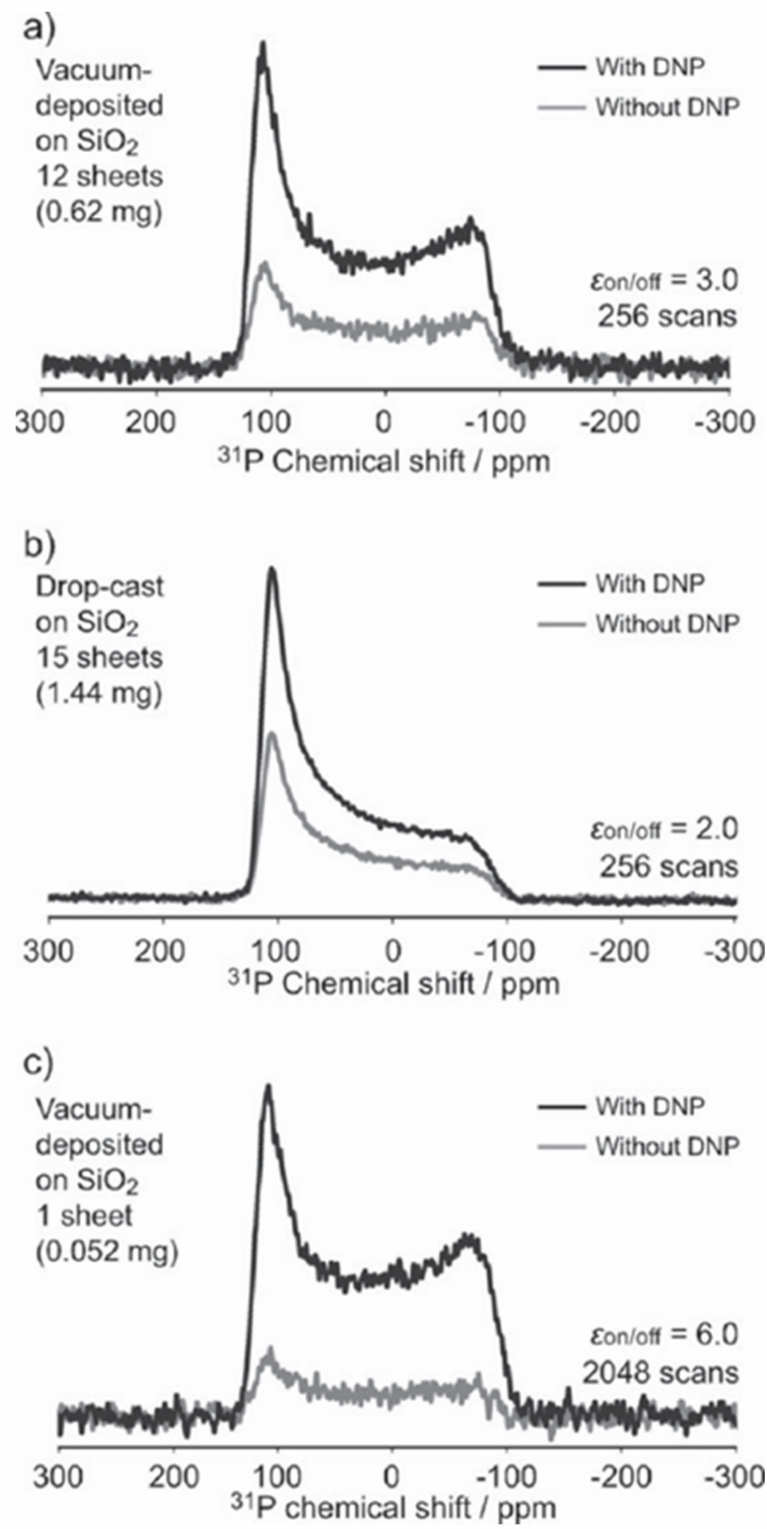
Figure 3. 31 P CSA NMR spectra for POPy 2 film with (black) and without (gray) DNP enhancement: ( a ) vacuum-deposited on SiO 2 (12 sheets), ( b ) drop-cast on SiO 2 (15 sheets) and ( c ) vacuum-deposited on SiO 2 (1 sheets). Reproduced with permission. [111] Copyright 2017, Angewandte Chemie,